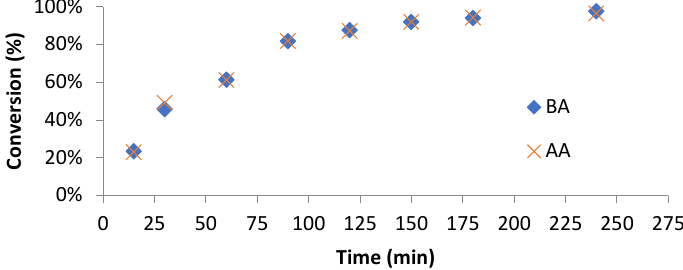
Figure 4. Conversion of butyl acrylate (BA) and acrylic acid (AA) during Oligo 1 [BM1481 (BA 6 - co - AA 9 )] synthesis. Co-polymerization was carried out at 70 °C in 1,4-dioxane (52 wt%) using AIBN as initiator and 1,3,5-trioxane as internal standard for NMR measurement.